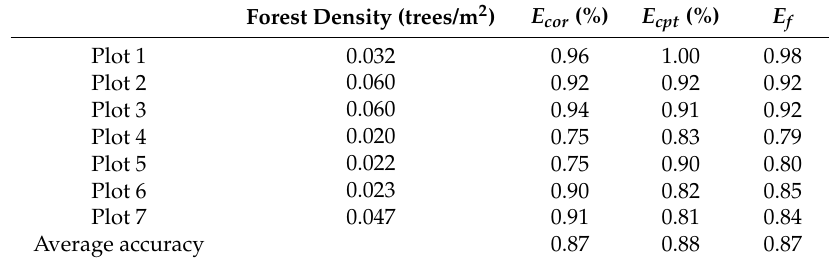
Figure 9. An example of segmentation results for Plot 5: ( a ) the watershed segmentation and ( b ) our proposed approach. Table 6. Single-tree segmentation results by the marker-controlled watershed segmentation method.